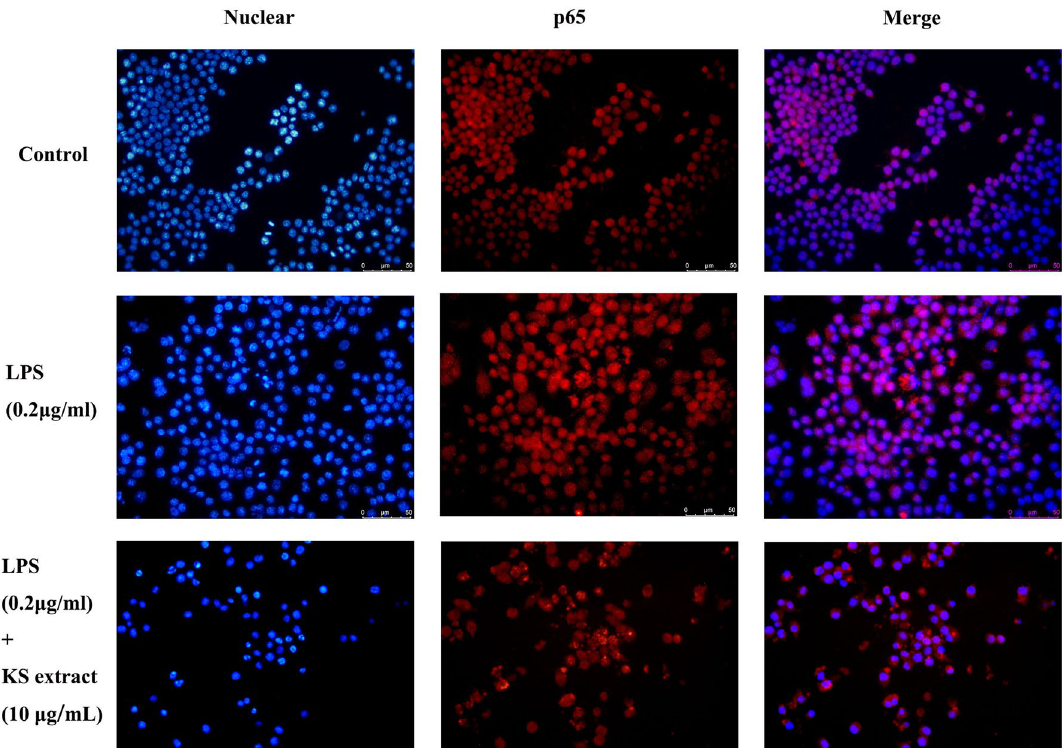
Figure 9. Effect of Kushen extract on the p65 subunit of NF-κB in RAW264.7 cells. The nuclear localization of the p65 subunit of NF-κB in ( A ) Control group, ( B ) LPS groups, and ( C ) LPS + Kushen extract were determined by